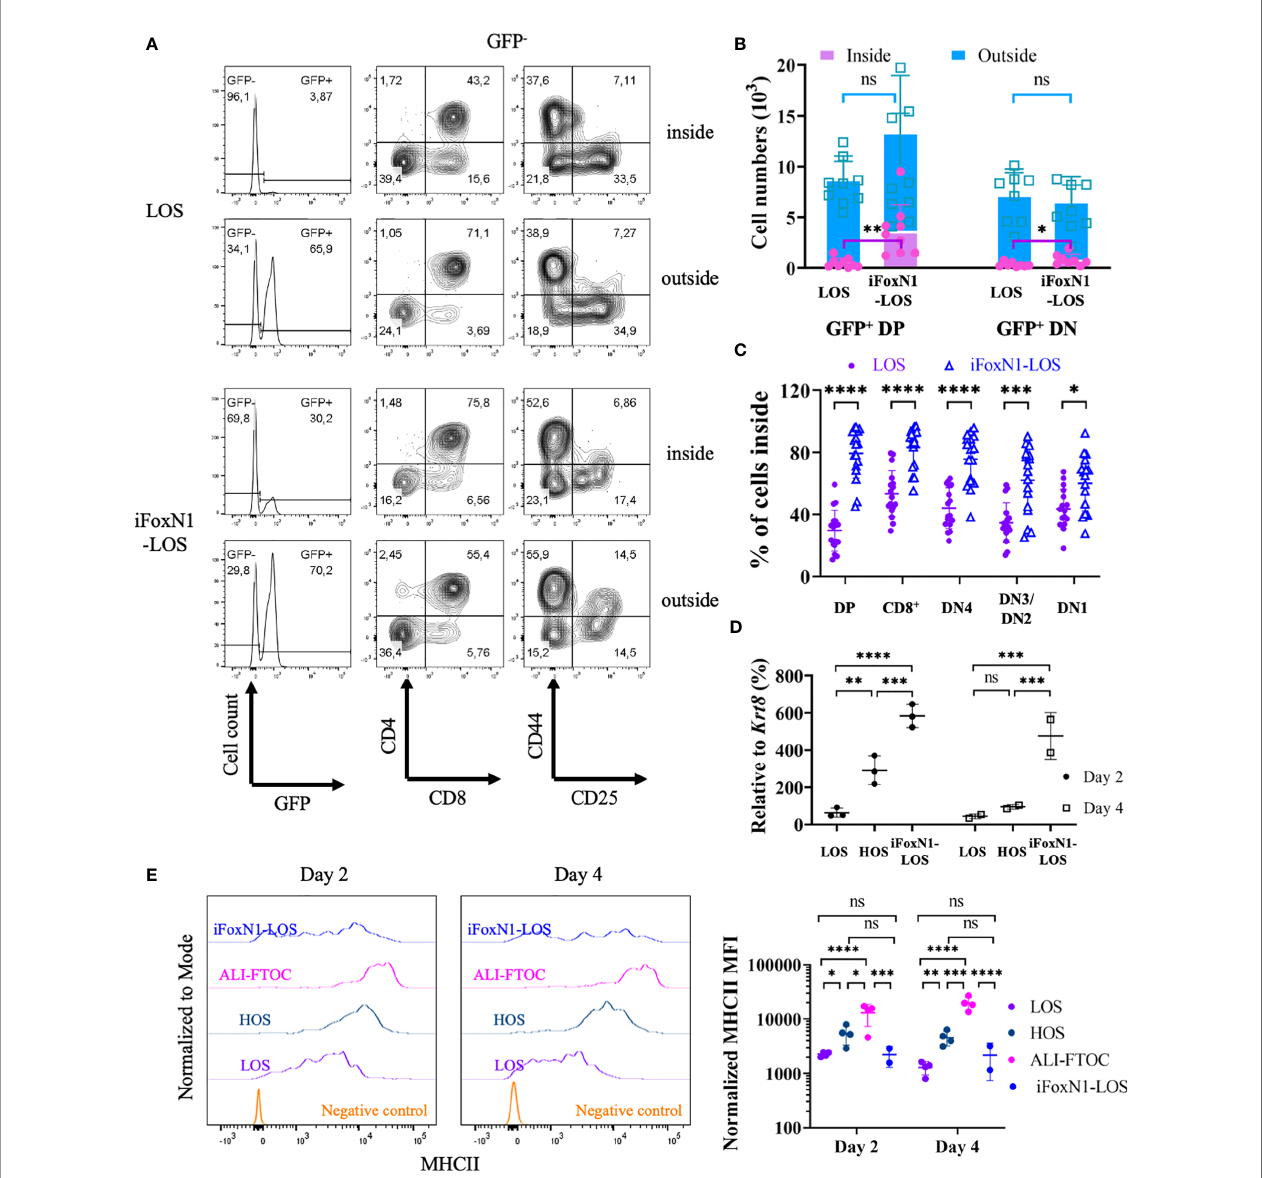
FIGURE 5 | Migration of CD4 + CD8 + cells in LOS cultures. (A) Flow cytometric analysis of cells inside and outside of lobes from LOS- and iFoxN1-LOS-FTOCs. Sorted GFP-expressing CD4 + CD8 + cells were added to LOS-FTOCs and all cells were analyzed after 1-day of culture. The left panels show histograms of GFP expression from CD45 + gd TCR − gated cells. The middle and right panels show CD4 and CD8 expression on CD45 + gd TCR − GFP − cells, and CD44 and CD25 expression on CD45 + gd TCR − GFP − CD4 − CD8 − cells, respectively. (B) Stacked column graphs and statistical analysis (unpaired Student ’ s t-test) of numbers of added GFP + CD4 + CD8 + (DP), or CD4 − CD8 − DN2/DN3 (DN) cells, inside and outside of lobes after 1-day of culture, as indicated. (C) Scatter dot plots and statistical analysis (unpaired Student ’ s t-test) of percentage (%) of endogenous (GFP - ) cells in different subsets that remained inside of the lobes after 1-day of culture, as indicated. (D) Scatter dot plots